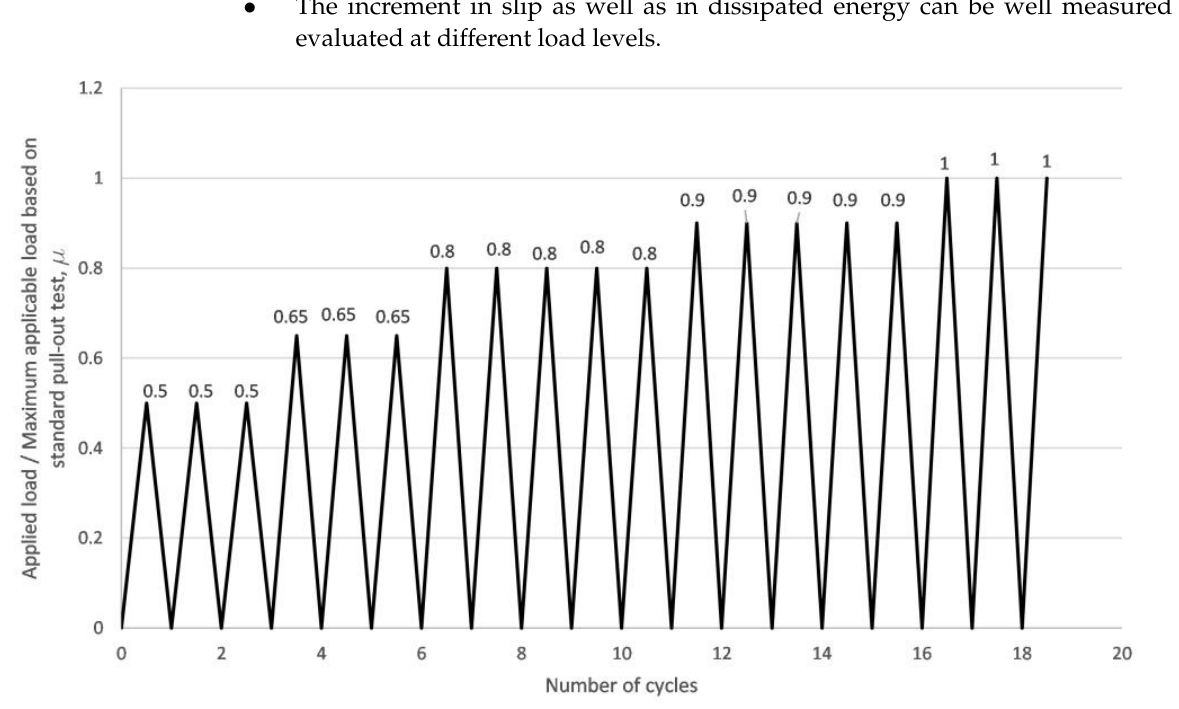
Figure 4. Force-controlled cyclic loading.